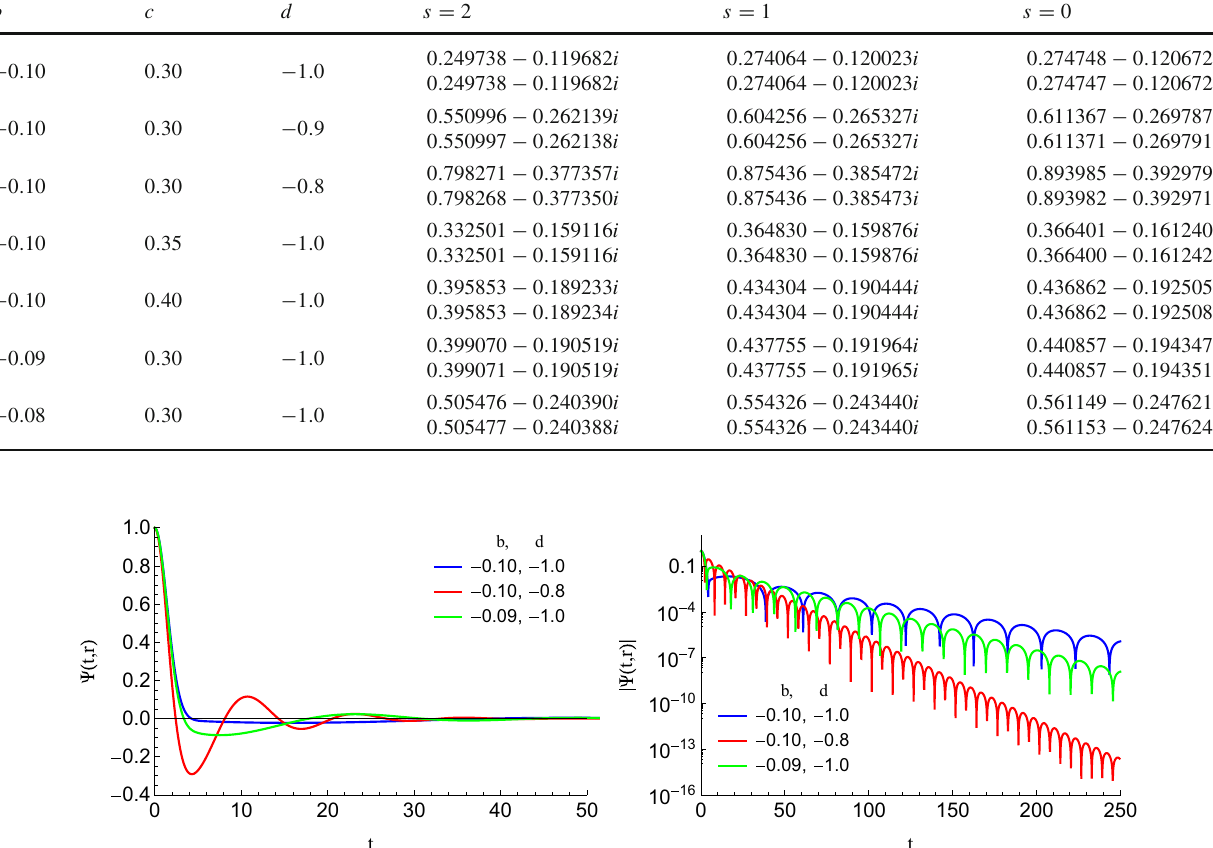
the left panel and right panel we find that the modes of all perturbations decay faster with more oscillations by increasing